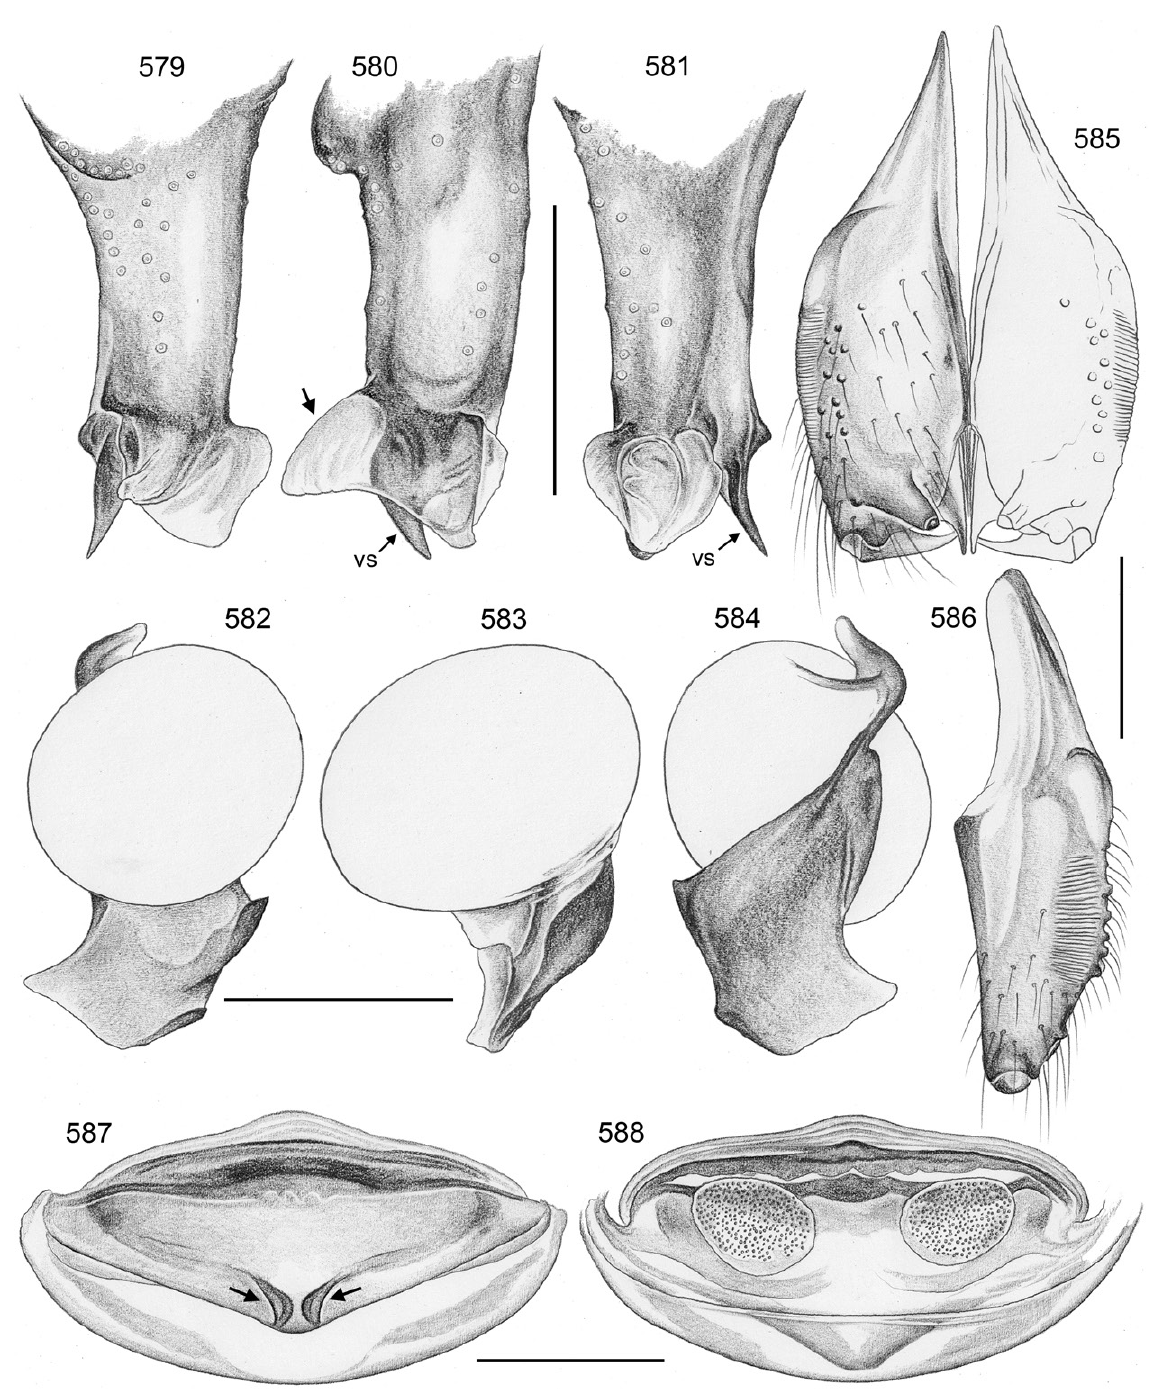
Figs 579–588. Crossopriza semicaudata (O. Pickard-Cambridge, 1876); male and female from Egypt, 5 km N of Aswan (CAS 9027139). 579–581 . Left procursus, prolateral, dorsal, and retrolateral views; arrow: distinctive prolateral process. 582–584 . Left genital bulb, prolateral, dorsal, and retrolateral views. 585–586 . Male chelicerae, frontal and lateral views. 587–588 . Cleared female genitalia, ventral and dorsal views; arrows: pockets. Abbreviation: vs = ventral sclerite. Scale bars = 0.3